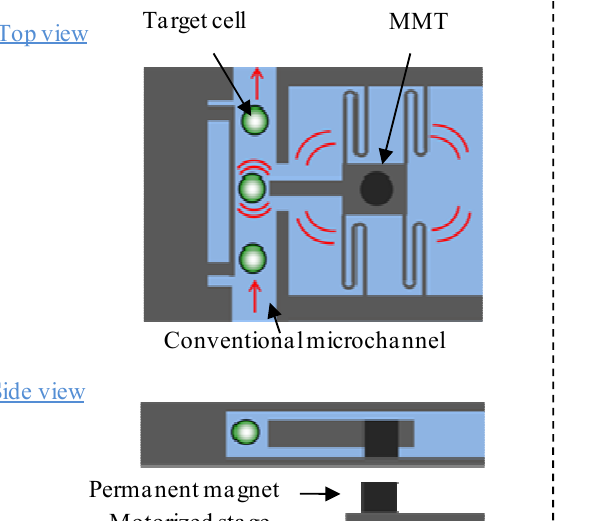
Figure 1. Surface-directed liquid flow for on-chip cell manipulation: ( a ) conventional microchannel and ( b ) surface-directed liquid